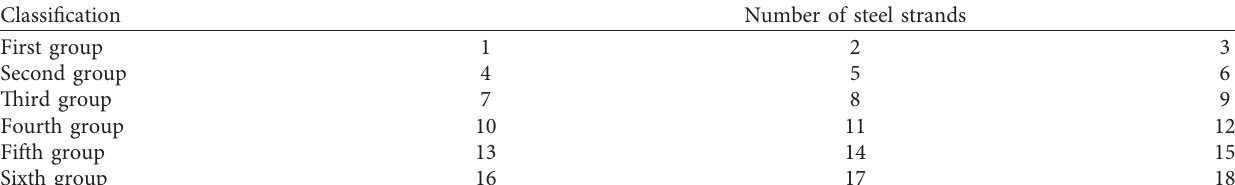
Table 2: Steel strand grouping table.